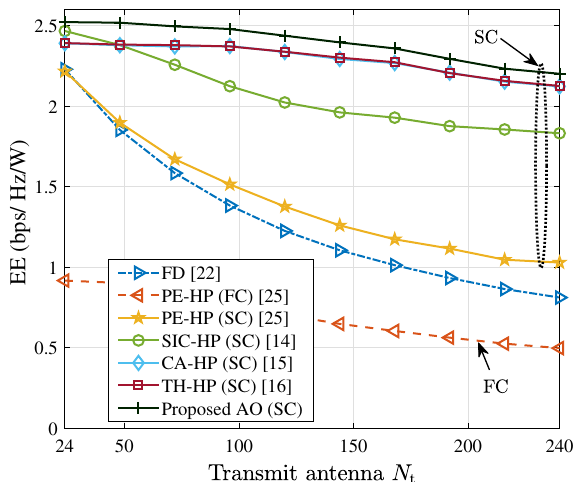
Fig. 8 EE versus the number of transmit antennas ( N t ). We set K = M = 12 and SNR = 0